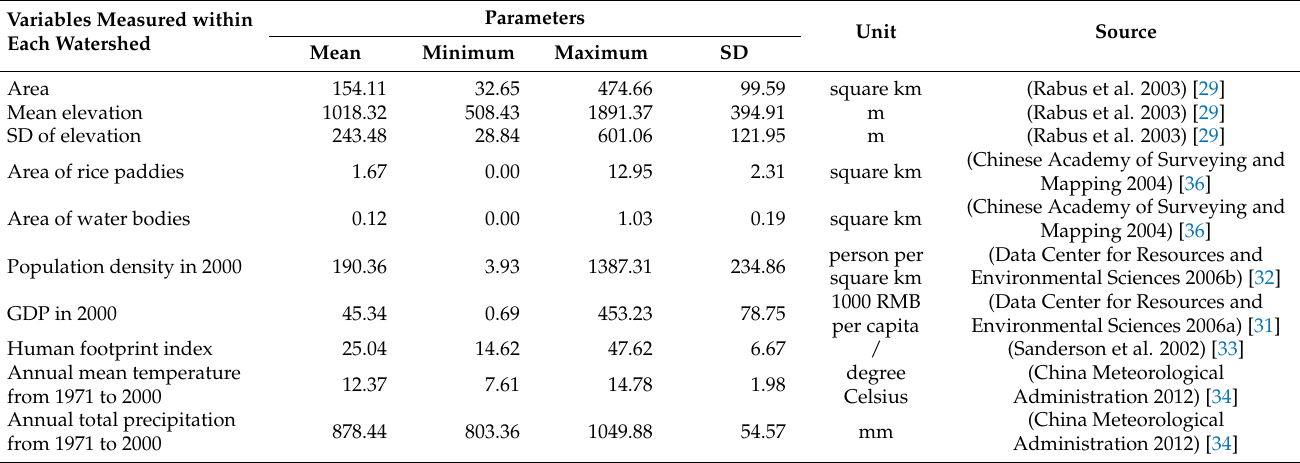
Table 1. Variable parameters and data sources used in the nest site selection analysis of crested